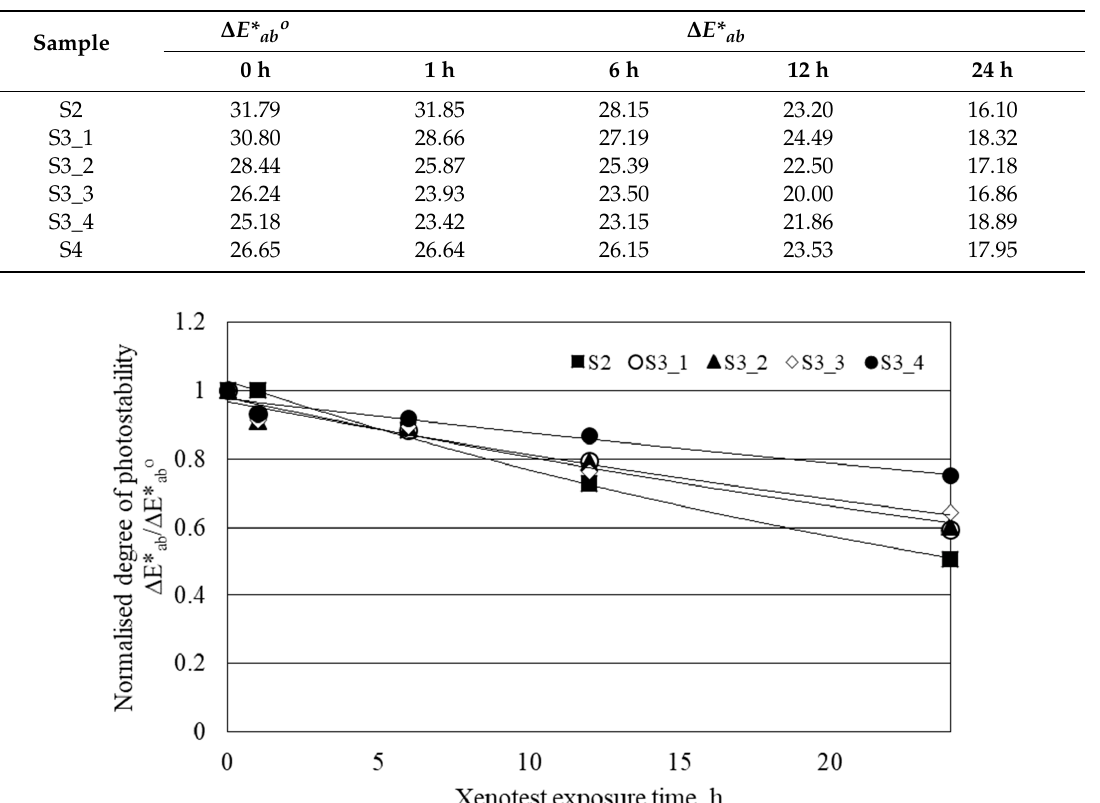
Table 8. Color di ff erence before ( ∆ E* abo ) and after di ff erent hours ( ∆ E* ab ) of illumination.